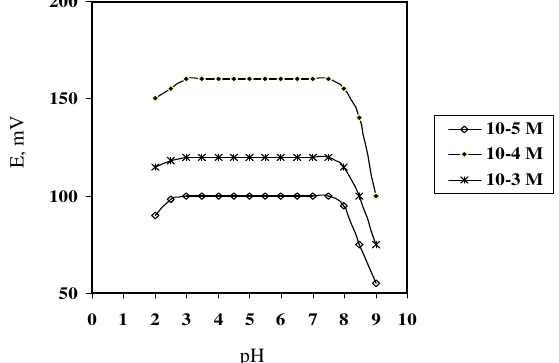
Figure 3. Effect of pH on the potential response of RTH-selective electrode for different